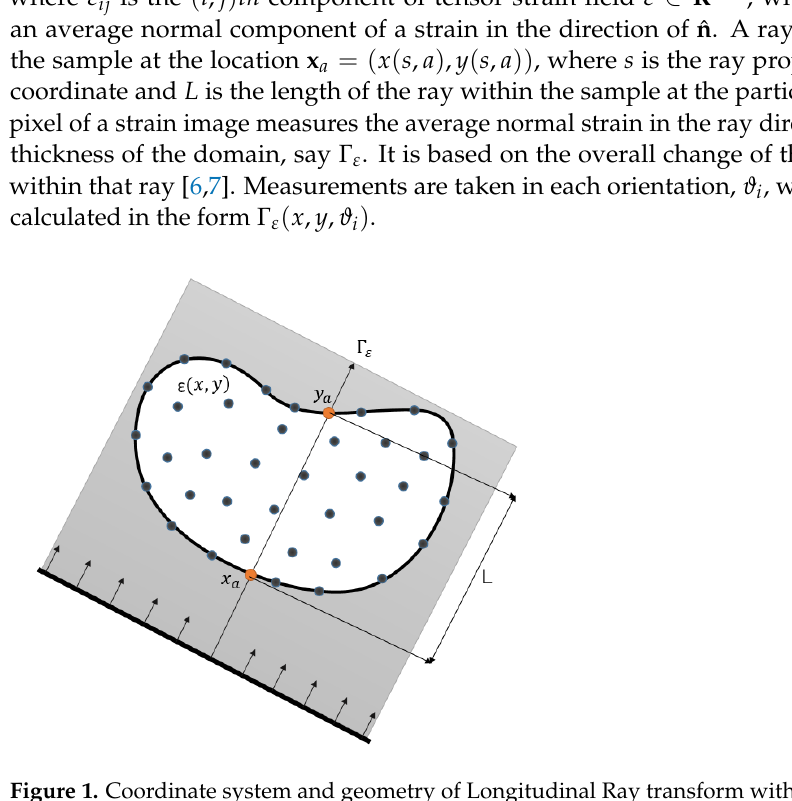
Figure 1. Coordinate system and geometry of Longitudinal Ray transform with the node